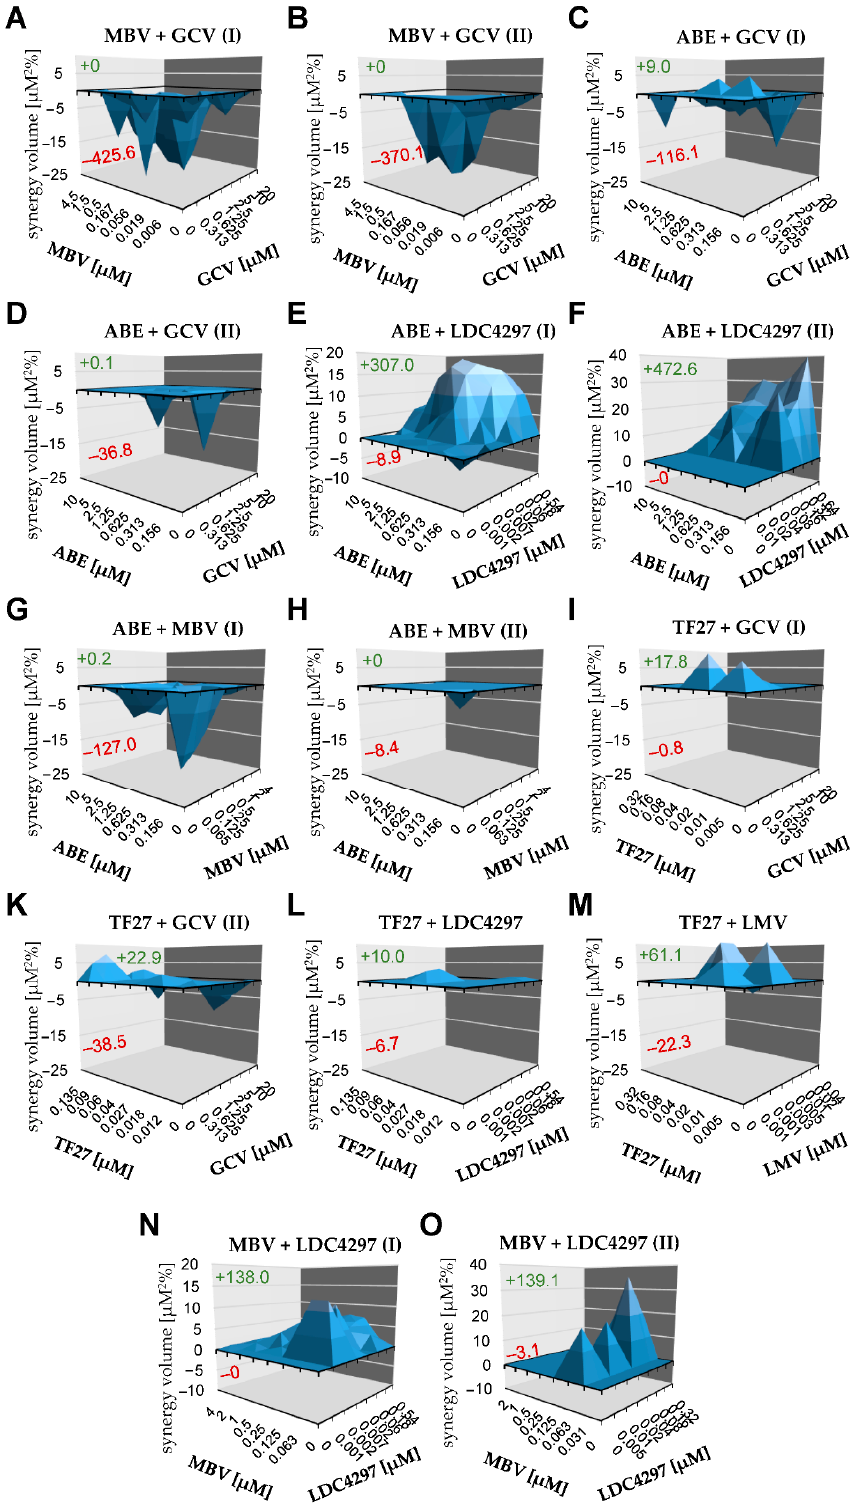
Figure 5. Bliss independence checkerboard assay results (HCMV-infected HFFs in all cases). ( A ) MBV + GCV (replicate I); ( B ) MBV + GCV (replicate II); ( C ) ABE + GCV (replicate I); ( D ) ABE + GCV (replicate II); ( E ) ABE + LDC4297 (replicate I); ( F ) ABE +LDC4297 (replicate II); ( G ) ABE + MBV (replicate I); ( H ) ABE + MBV (replicate II); ( I ) TF27 + GCV (replicate I); ( K ) TF27 + GCV (replicate II); ( L ) TF27 + LDC4297; ( M ) TF27 + LMV; ( N ) MBV + LDC4297 (replicate I); ( O ) MBV + LDC4297 (replicate II).